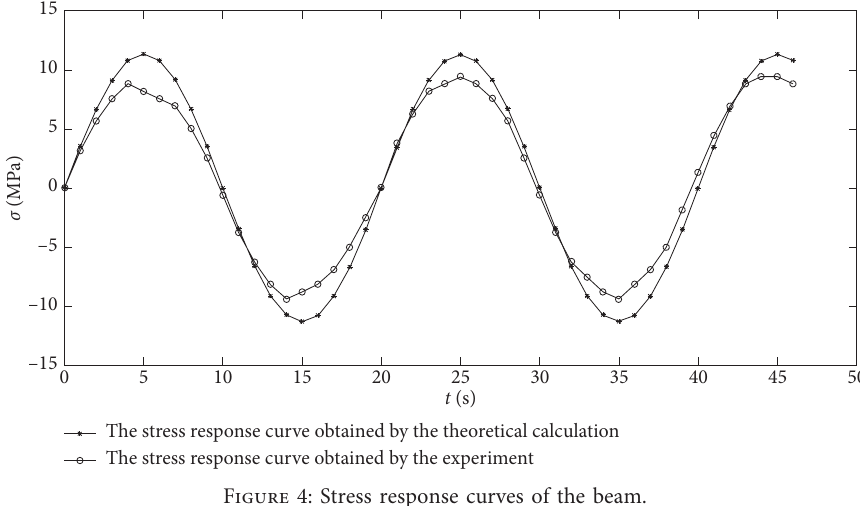
Figure 4: Stress response curves of the beam.